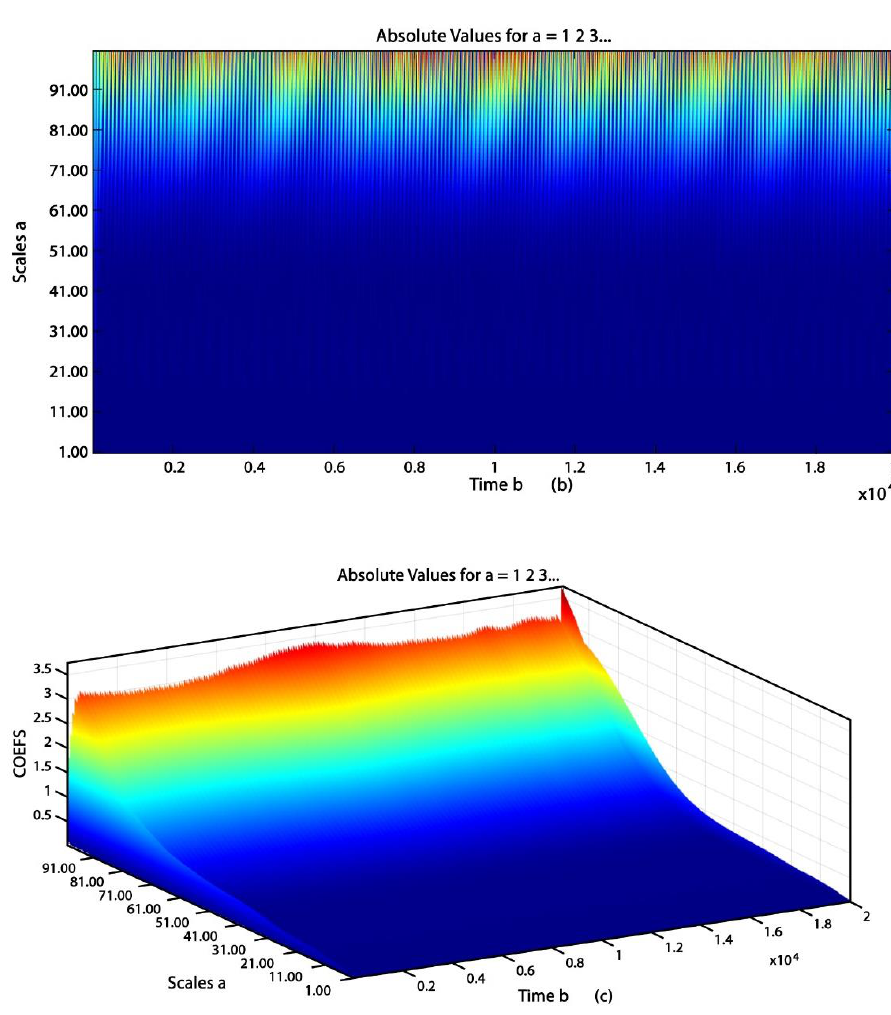
Figure 9. Application of the wavelet transform to the SCIG signal. ( a ) Decomposition of the current signal using the DWT, ( b ) 2-dimensional continuous wavelet transform, ( c ) 3-dimensional continuous wavelet transform.